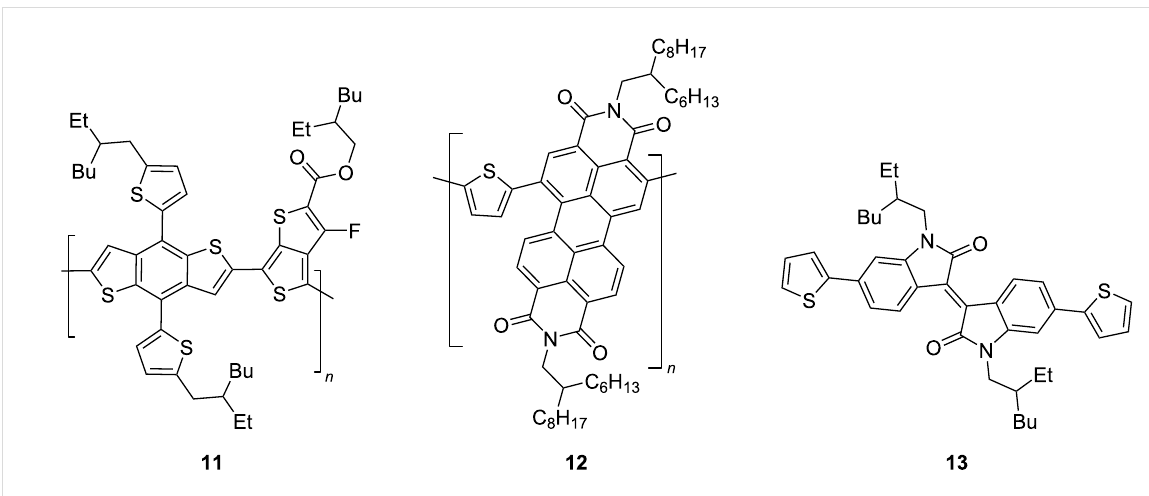
Scheme 9: Isoindigo as an additive in all-polymer OSCs.